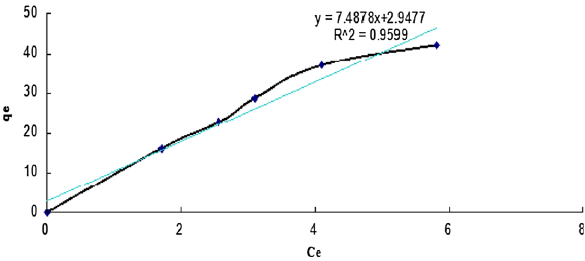
Fig. 5 Langmuir equilibrium isotherm for the adsorption of As(III) onto